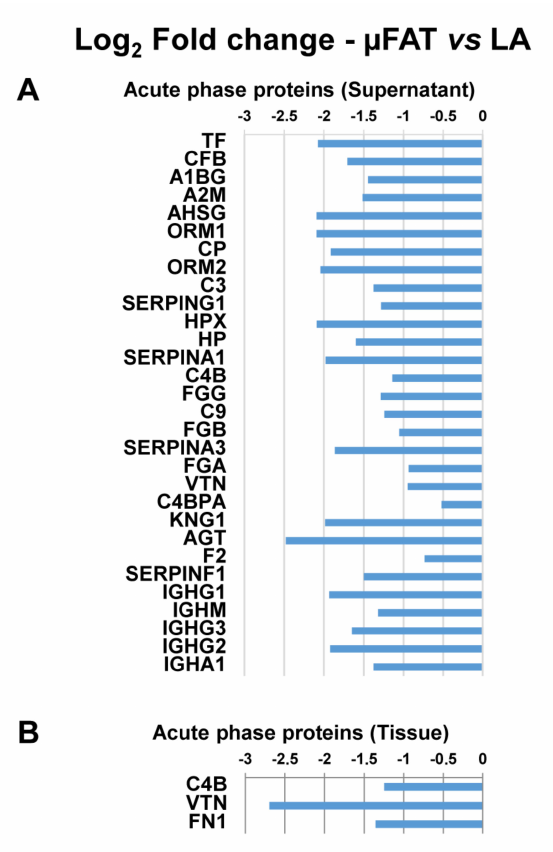
Figure 5. Modulated Acute phase proteins in µ FAT vs. LA supernatants and comparison with tissues. All displayed proteins are significantly modulated ( p -value < 0.05). ( A ) Supernatant. ( B )